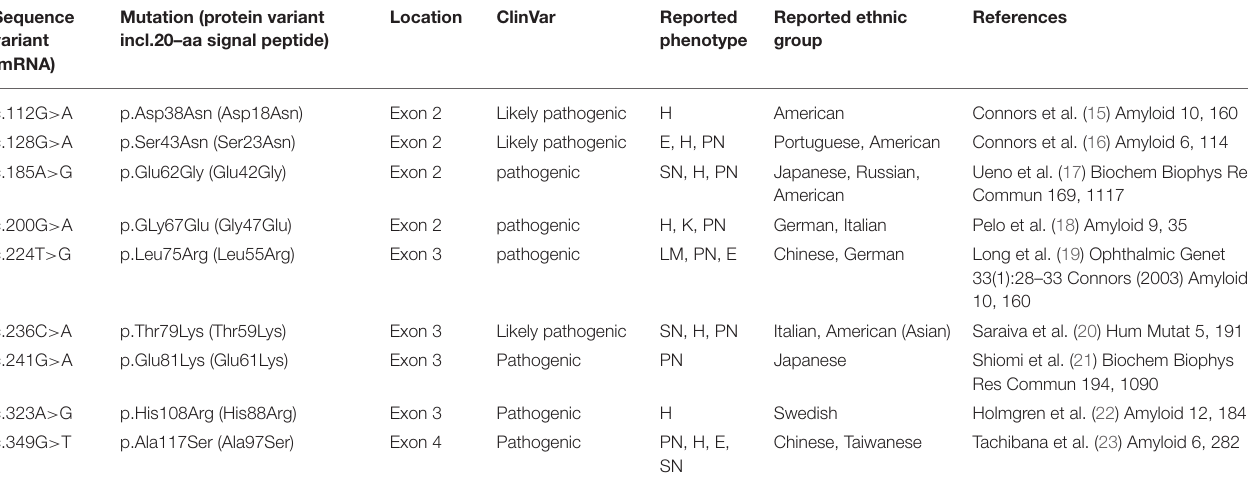
TABLE 4 | Bioinformatic results of the identified missense TTR mutations. Sequence